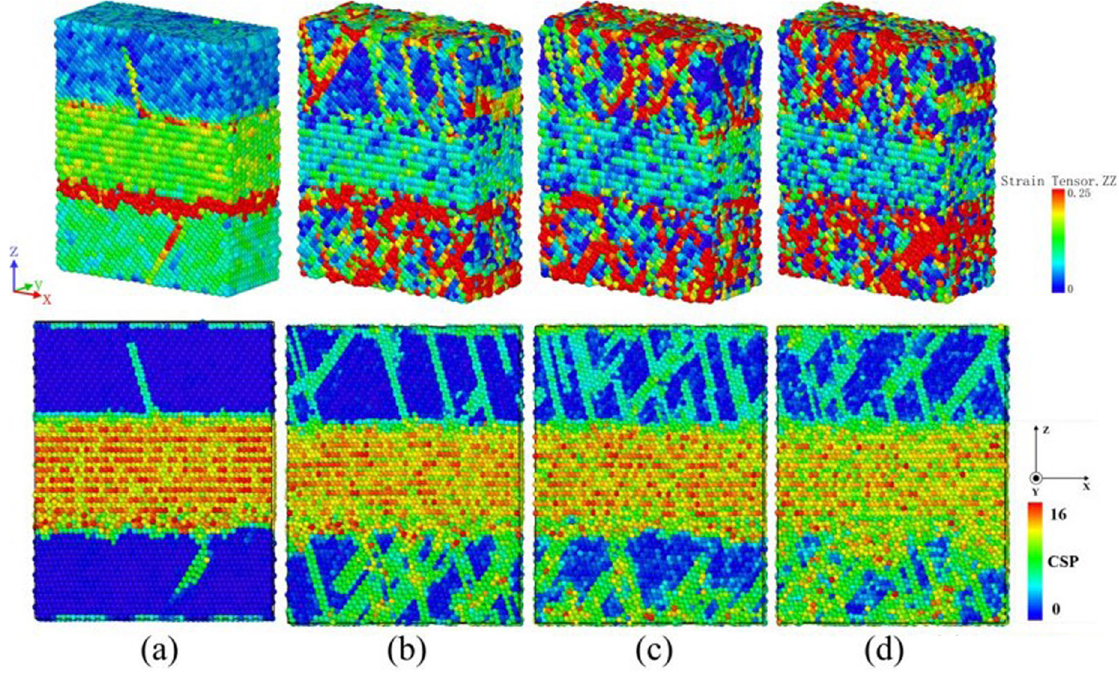
Figure 9: The distribution of the local plastic deformation and evolution of atomic con fi guration of the Cu ( 111 ) /Al 2 Cu ( 1¯ 10 ) /Al ( 111 ) interface model at a strain of 0.11. ( a ) 100 K, ( b ) 300 K, ( c ) 500 K, and ( d ) 700